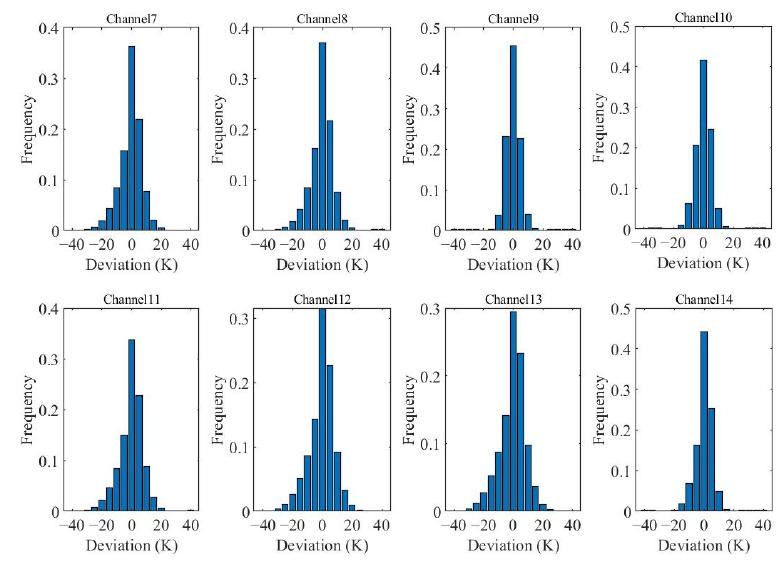
Figure 7. The frequency distributions of deviation values.